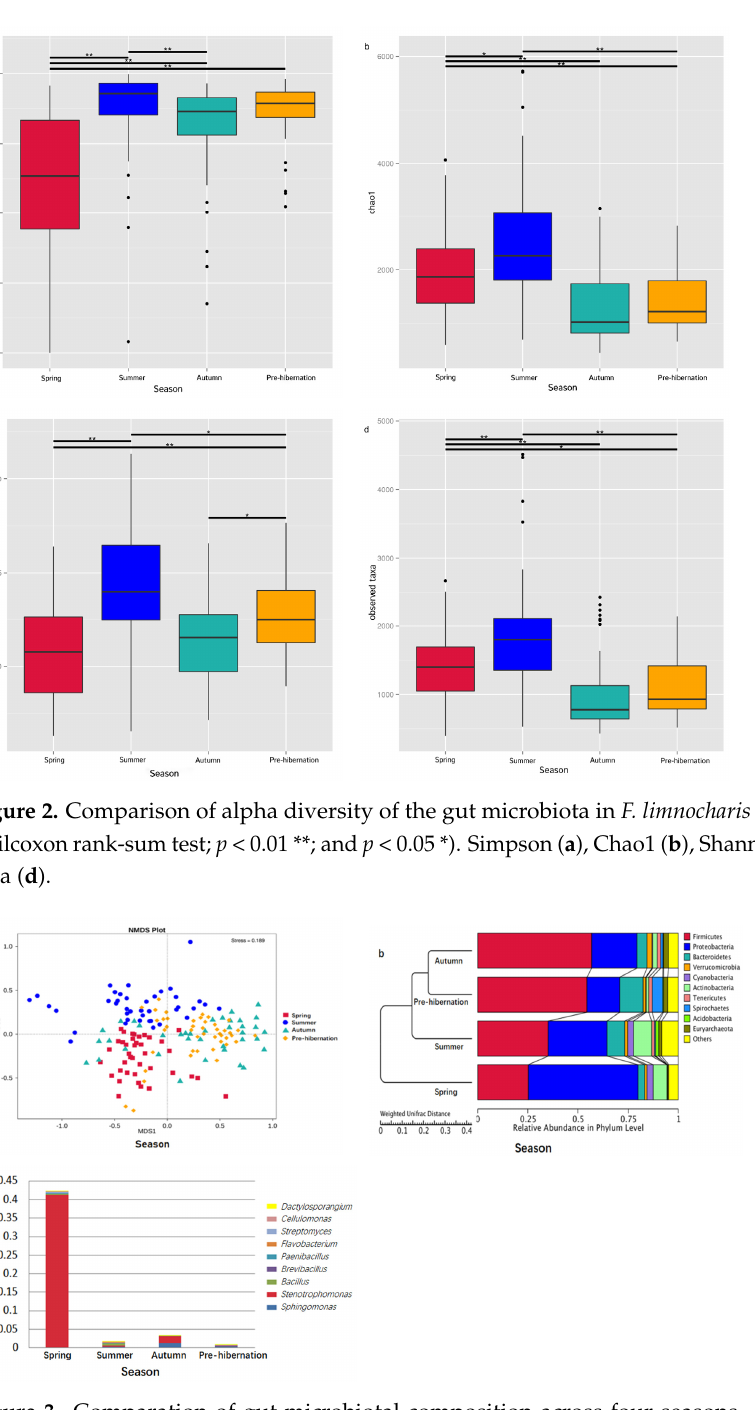
Figure 3. Comparation of gut microbiotal composition across four seasons. ( a ) NMDS analysis between different individuals based on OTUs. Each point in the graph represents a sample, the distance between points indicates the degree of difference, samples in the same group are represented in the same color, when the stress <0.2, NMDS can accurately reflect the differences between groups and within groups of samples. ( b ) The UPGMA cluster analysis of different seasonal samples in weighted UniFrac distances. The UPGMA cluster tree structure is shown on the left side of the figure; the relative abundance distribution of each sample at the phylum level is shown on the right side. Others represent the sum of the relative abundances of all the other phyla outside the 10 phyla in the graph. ( c ) Comparison of chitin-digesting bacteria in F. limnocharis at different